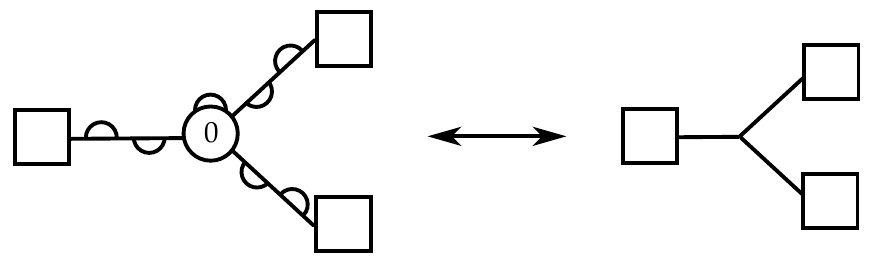
Figure 9 . Duality to trinion theory: three copies of T (SU( N )) (cid:24) = T N .